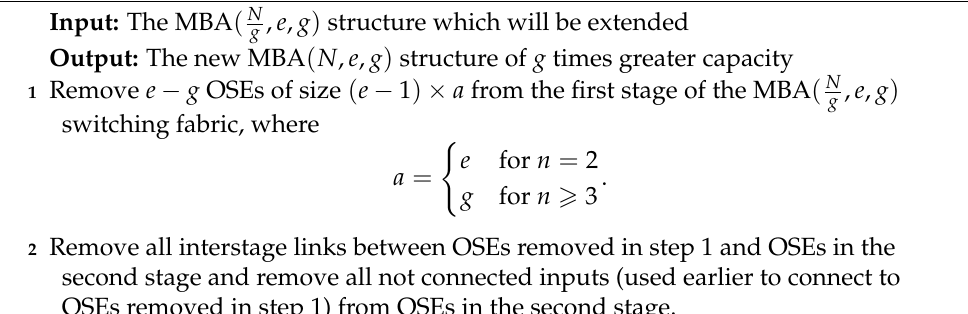
Algorithm 1 Constructing the MBA ( N , e , g ) switching